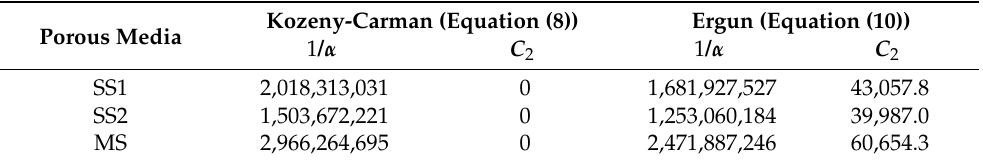
Table 3. Equivalent values of the inverse of the permeability (=1/ α ) and inertial resistance factor ( C 2 )